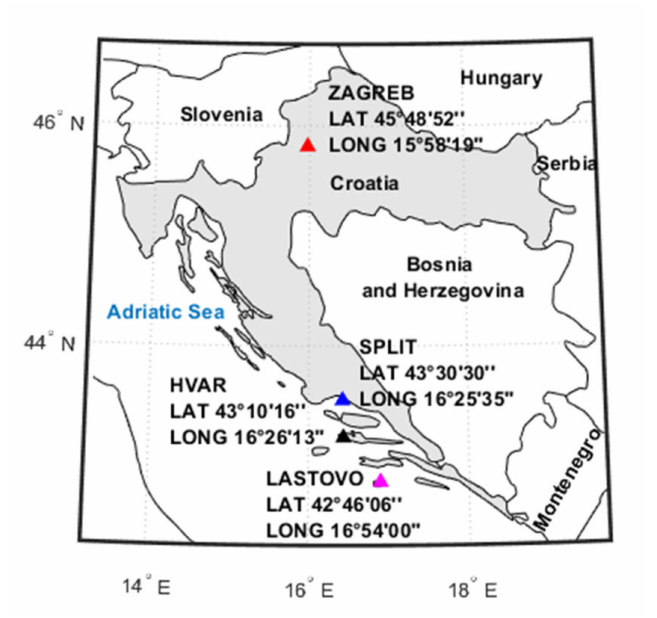
Figure 1. Study area